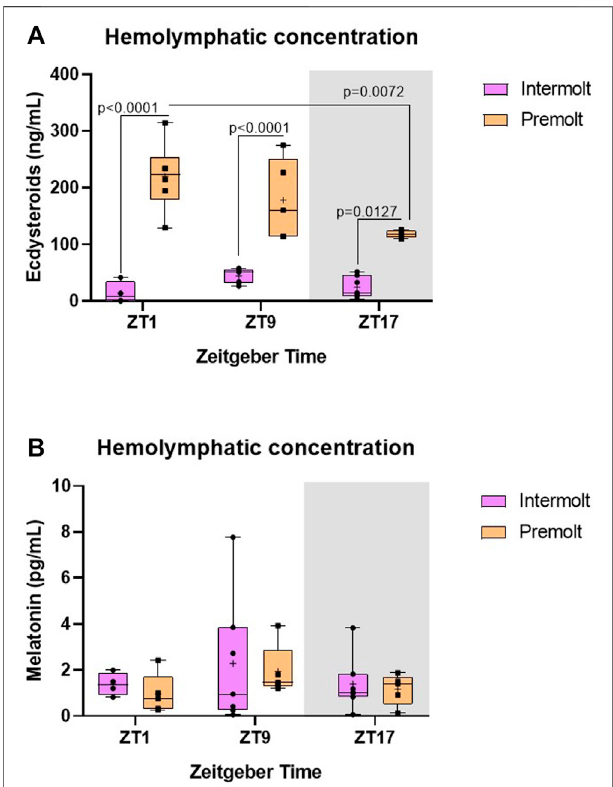
FIGURE 3 | Concentration of ecdysteroids and melatonin in C. sapidus hemolymph. (A) Ecdysteroids ( n = 4 – 7) and (B) melatonin ( n = 4 – 7) were extracted 1, 9 and 17 h after lights on. The values are expressed as median, quantiles, maximum, and minimum concentration. p values refer to the differences between molt stages, or temporal points within a single molt group, as determined by Two-way ANOVA, followed by Bonferroni post-test. Inthisandthefollowing fi gures,thegrayrectanglerepresentsthescotophase, and n is the animal number.